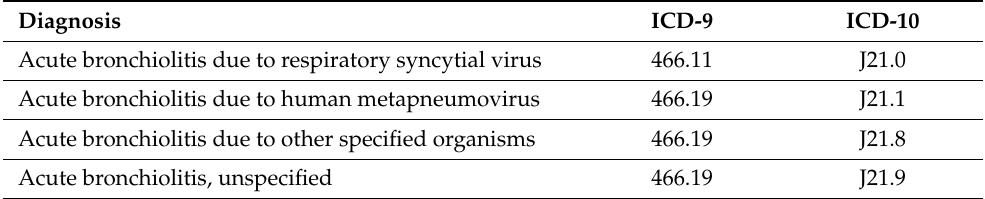
Table A1. List of ICD-9 and ICD-10 codes associated with the diagnoses used to select patients for the